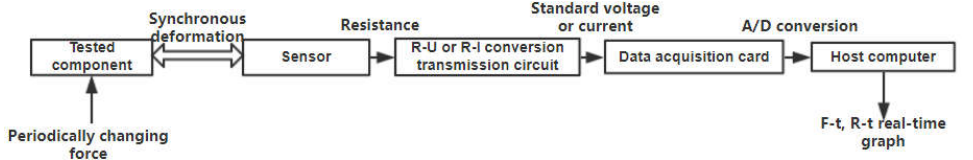
Figure 5. Polymer-based flexible sensor signal acquisition and processing flow chart.